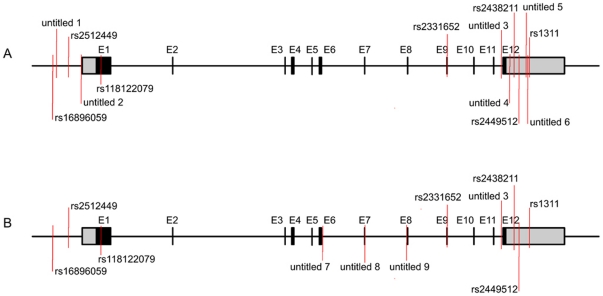
The distribution of detected variants of MTDH.The black blocks stand for the 12 exons and the grey blocks represent for the 3′UTR and 5′UTR respectively. The red line marked the location of each variant in MTDH. A. Control group. B. Case group.